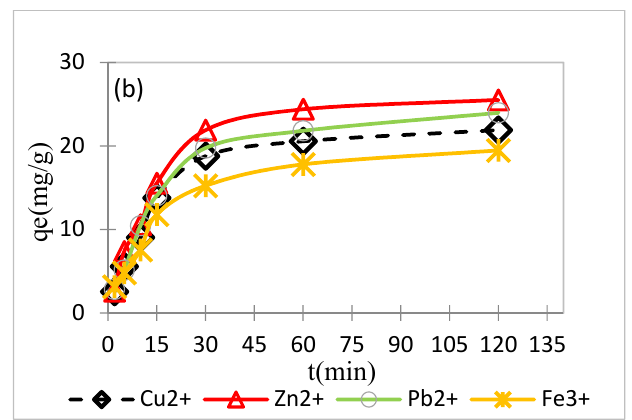
Figure 5. Effect of contact time on the removal of Cu 2+ , Zn 2+ , Pb 2+ , and Fe 3+ by IIP/Mt ( a ), and NIP/Mt ( b ). Conditions: initial Cu 2+ concentration = 20 mg/L, and pH = 5.